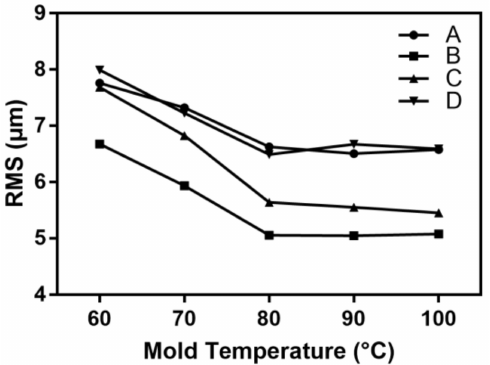
Figure 7. The influence of mold temperature on the RMS of the microchannel.